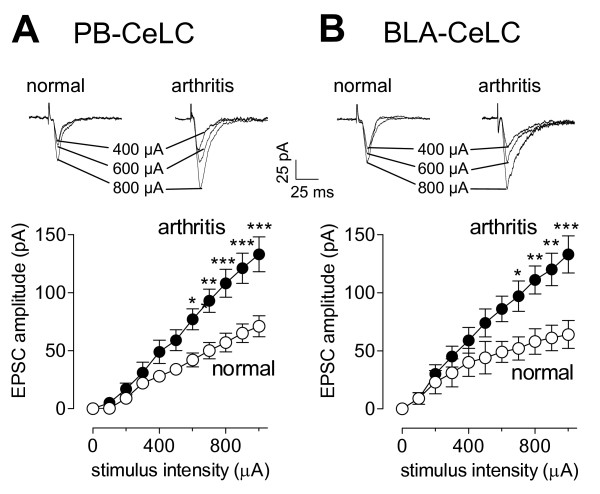
Synaptic plasticity in CeLC neurons in the arthritis pain model. Input-output functions of CeLC neurons were measured in slices from arthritic animals (6 h postinduction) and in slices from normal animals. Monosynaptic excitatory postsynaptic currents (EPSCs) were evoked in CeLC neurons by electrical stimulation of the PB-CeLC (A) and BLA-CeLC (B) synapses with increasing intensities. Input-output curves were generated by plotting peak EPSC amplitude (pA) as a function of afferent fiber volley stimulus intensity (μA). Input-output functions of neurons from arthritic animals (n = 19) were significantly different from those of control neurons (n = 16) at the PB-CeLC (P < 0.0001, F 1,363 = 66.65) and BLA-CeLC (P < 0.0001, F 1,363 = 43.30, two-way ANOVA) synapses. Individual traces (mean of 8–10 trials) show monosynaptic EPSCs recorded in one CeLC neuron from a normal rat and another CeLC neuron from an arthritic rat. Whole-cell voltage-clamp recordings were made at -60 mV. * P < 0.05, ** P < 0.01, *** P < 0.001 (Bonferroni post-tests).